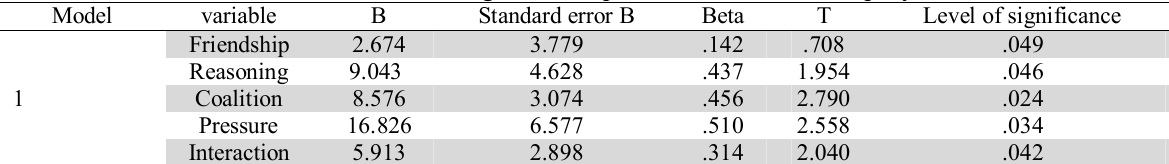
The coefficient of variables used in the regression equation for the male employees